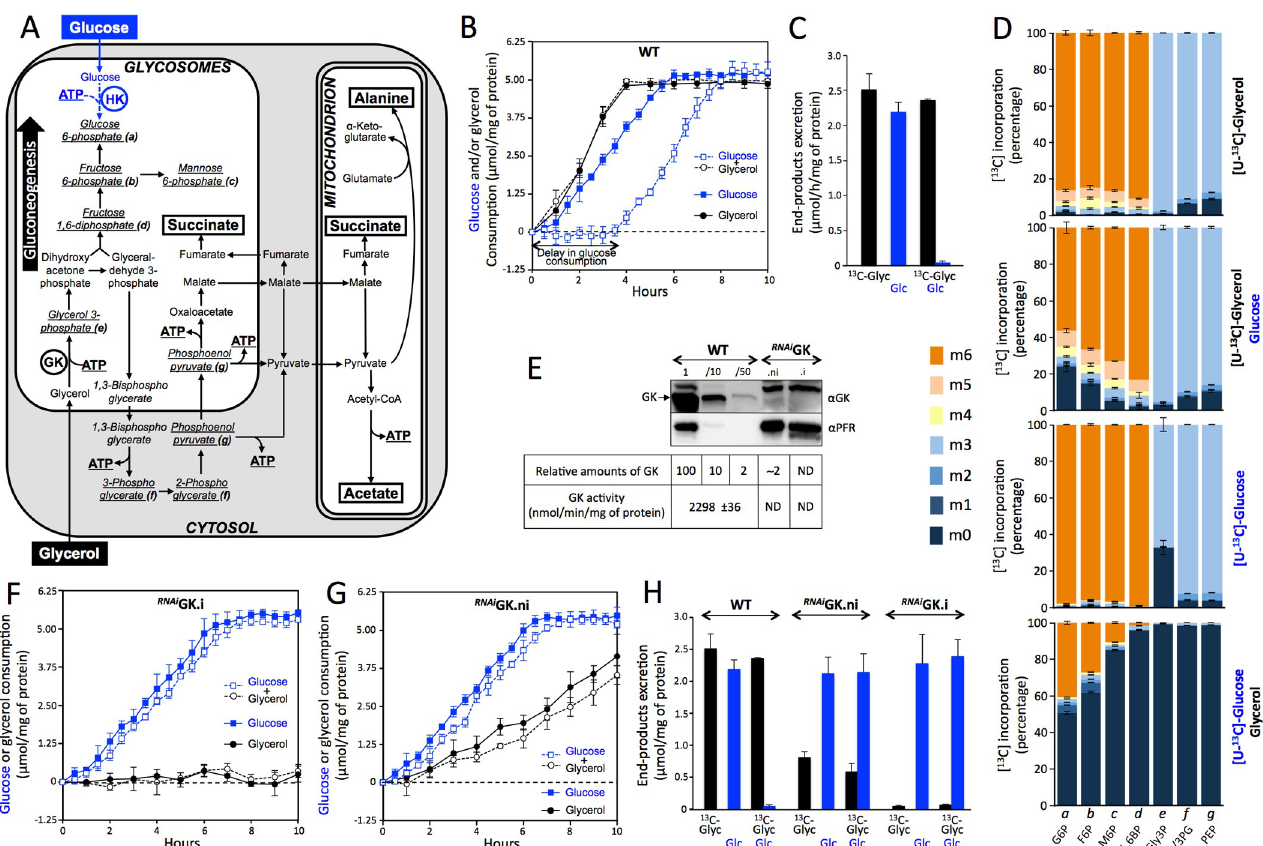
Fig 1. Procyclic trypanosomes prefer glycerol to glucose. (A) Schematic representation of glycerol (black) and glucose (blue) metabolism in procyclic form (PCF) trypanosomes. The metabolic end products are shown in rectangles, and metabolites analyzed by ion chromatography high-resolution mass spectrometry (IC-HRMS) are underlined and in italic ( a–g ). The ATP molecules consumed and produced by substrate-level phosphorylation are shown, as well as the enzymes hexokinase (HK) and glycerol kinase (GK). (B) Glucose and glycerol consumption by PCF trypanosomes incubated in glucose (2 mM), glycerol (2 mM) and glucose + glycerol (2 mM each) conditions. (C) Metabolic end products produced by PCF trypanosomes from [U- 13 C]-glycerol ( 13 C-Glyc) and/or glucose (Glc), as measured by proton nuclear magnetic resonance ( 1 H-NMR) spectroscopy (the values are calculated from the data presented in S1 Table). (D) IC-HRMS analyses of intracellular metabolites collected from PCF trypanosomes after incubation with 2 mM [U- 13 C]-labeled carbon sources in the presence or not of unlabeled carbon sources, as indicated on the right margin. The figure shows the proportion (%) of molecules having incorporated 0 to 6 13 C atoms (m0 to m6, color code indicated on the left margin). G6P ( a ), glucose 6-phosphate; F6P ( b ), fructose 6-phosphate; M6P ( c ), mannose 6-phosphate; F1,6BP ( d ), fructose 1,6-bisphosphate; Gly3P ( e ), glycerol 3-phosphate; 2/3PG, 2- or 3-phosphoglycerate (which are not undistinguished by IC-HRMS); PEP ( g ), phosphoenolpyruvate. (E) Western blot analysis of total protein extracts from the parental (wild-type [WT]) and tetracycline-induced (.i) or uninduced (.ni) RNAi GK cell line probed with anti-GK ( α GK) and anti-paraflagellar-rod ( α PFR) immune sera. The table below the blots shows the relative levels of GK expression in 5 × 10 6 (1), 5 × 10 5 (/10) and 10 5 (/50) parental cells, and 5 × 10 6 RNAi GK.ni and RNAi GK.i cells, as well as the corresponding GK activity. ND, not detectable. (F and G) Glucose and glycerol consumption by the (F) tetracycline-induced RNAi GK ( RNAi GK.i) and (G) uninduced RNAi GK ( RNAi GK.ni) mutant cell lines incubated in glucose (2 mM), glycerol (2 mM) and glucose + glycerol (2 mM each) conditions. (H) Production of metabolic end products by the parental (WT), RNAi GK.ni, and RNAi GK.i cell lines from [U- 13 C]-glycerol ( 13 C-Glyc) and/or glucose (Glc), as measured by 1 H-NMR spectroscopy (the values are calculated from the data presented in S1 Table). Data supporting the results described in this figure can be found at https://zenodo.org/record/5075637#. YORd2B069yA.